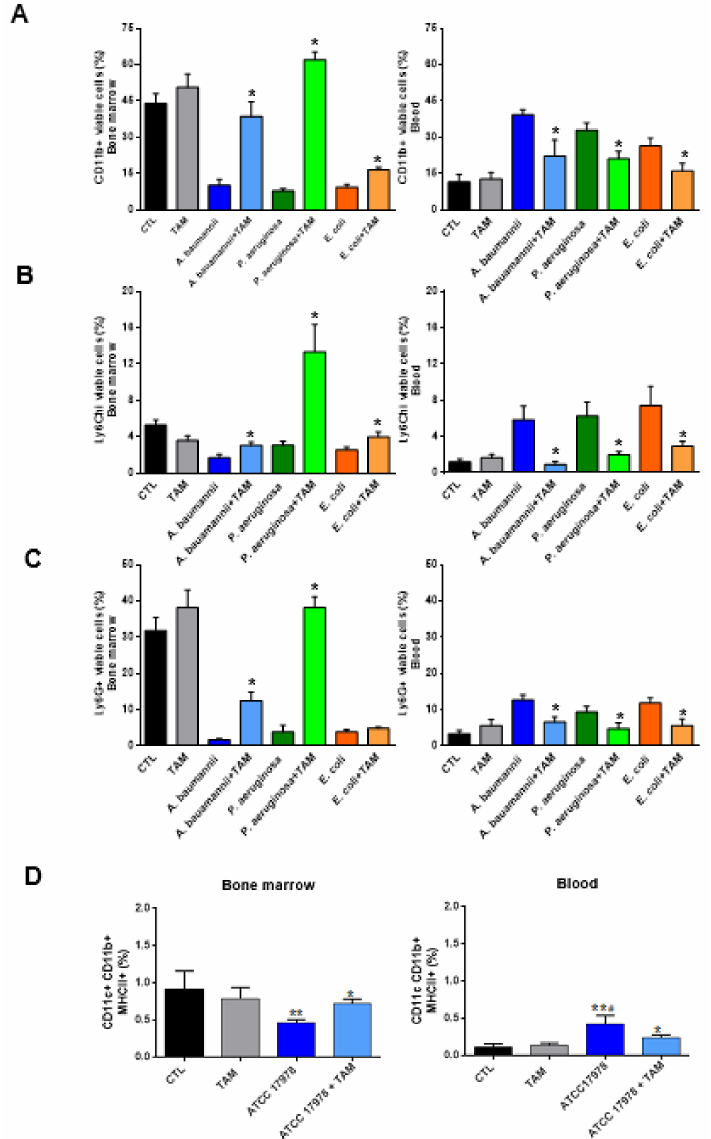
Figure 4. Tamoxifen impairs, after bacterial infection, the migration of immune cells from the bone marrow to the blood. Mice received firstly tamoxifen (80 mg/kg/d, for three days), followed by infection with minimal lethal dose 100 of A. baumannii ATCC17978, P. aeruginosa PAO1, or E. coli ATCC25922 strains. Twenty-four hours post-infection, ( A ) myeloid cells, ( B ) inflammatory monocytes, ( C ) neutrophils and ( D ) Tip-DC were identified as CD11b+, CD11b+Ly6C hi , CD11b+Ly6G+, and CD11b+CD11c+MHII+ respectively, by flow cytometry in the bone marrow and blood of mice. Data are representative of five/six mice per group and are expressed as mean ± SEM. * p < 0.05: treated vs. infected. ** p < 0.05: CTL vs. infected, # p < 0.05: TAM vs. infected. CTL: non-infected mice, TAM: tamoxifen, %: the percentage of myeloid cells, inflammatory monocytes, neutrophils and Tip-DC from total cells in bone marrow or